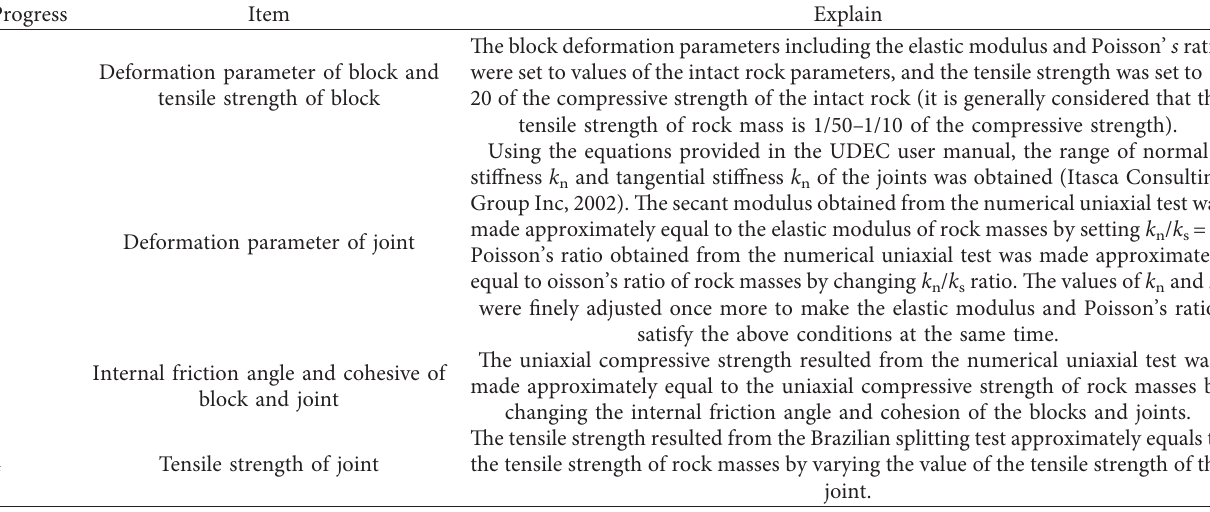
Table 3: Parameter calibration process of block and joint.